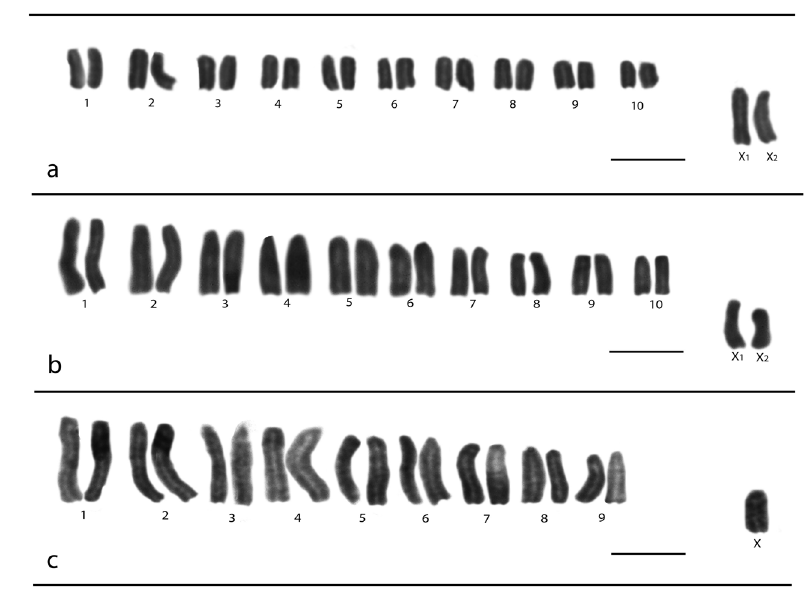
X 0 of the Mata dos Godoy State Park, 1 2 X 0 of the State University of 1 2